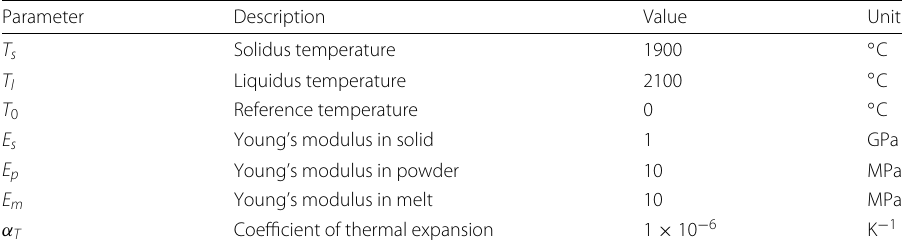
Table 1 Material parameters for one-dimensional simulations Parameter Description Value Solidus